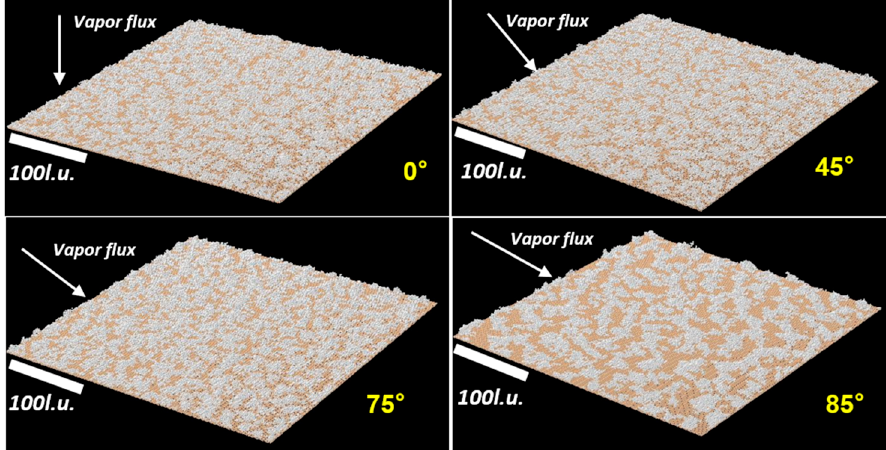
Figure 5. Film growth simulation results at the initial island growth stage (0.5 mL) under different deposition angles.